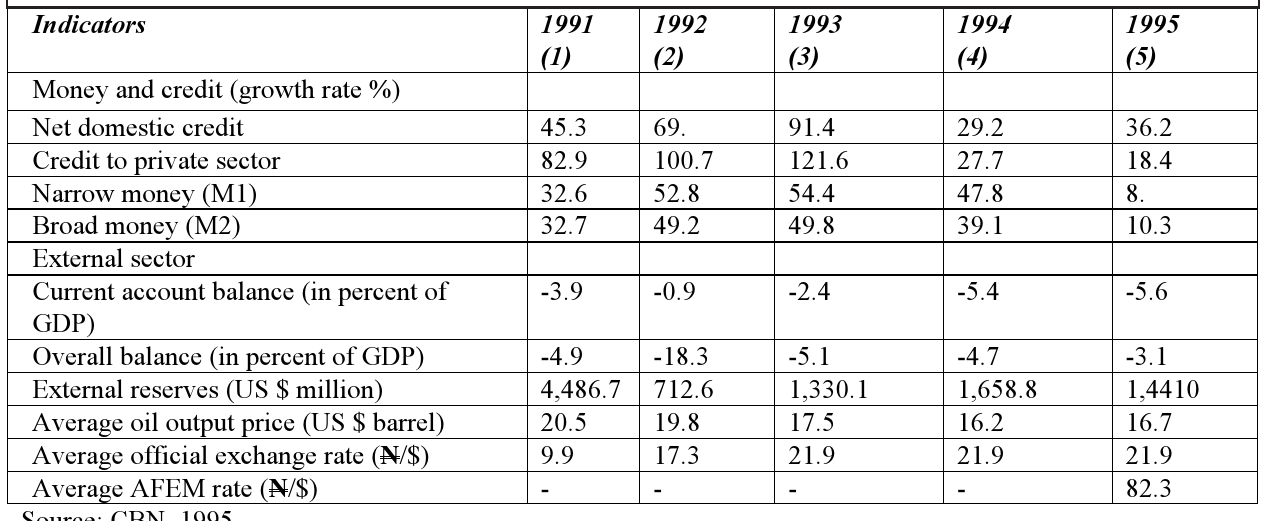
Table 11. Selected Macroeconomics Indicators